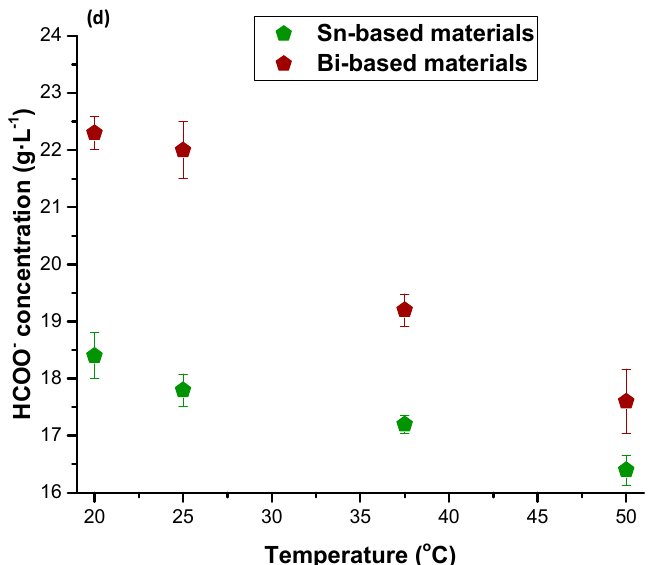
Figure 3. Influence of temperature on ( a ) Faradaic E ffi ciency for HCOO − (%), ( b ) HCOO − rate (mmol · m − 2 · s − 1 ), ( c ) energy consumption per kmol of HCOO − (kWh · kmol − 1 ), and ( d ) HCOO − concentration (g · L − 1 ) in the temperature range of 20–50 ◦ C applied at a constant current density = 45 mA · cm − 2 , a catalyst loading = 0.75 mg · cm − 2 , and a relative humidity = 100%. Sn / C-CCMEs and Bi / C-CCMEs are indicated in green and red, respectively. Data taken from references [67,69].